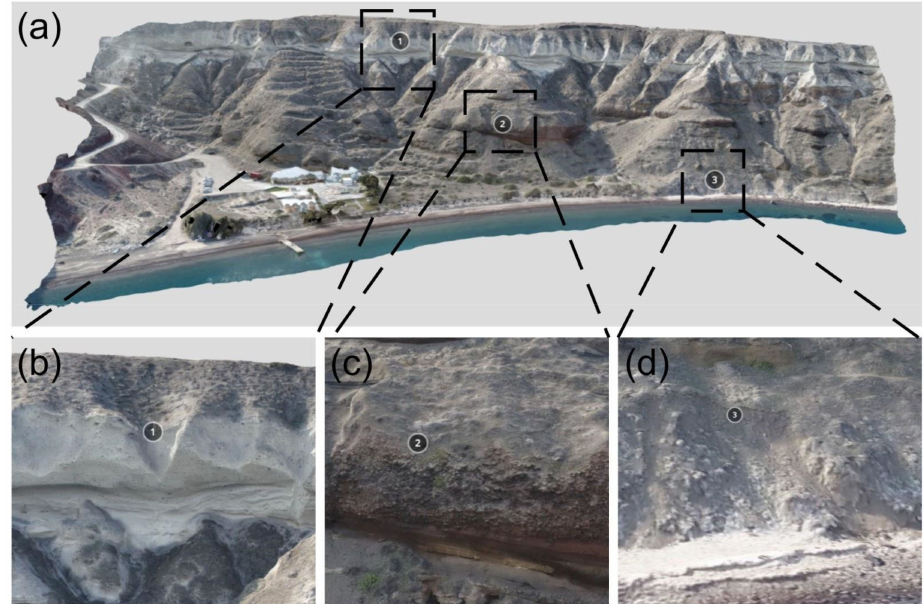
Figure 10. ( a ) A panorama of the sandy beach 3D model (view towards the south). A closer look at ( b ) the Cape Riva tuffs, ( c ) the US2 deposit dominated by grey scoria flow, and ( d ) the middle tuffs.